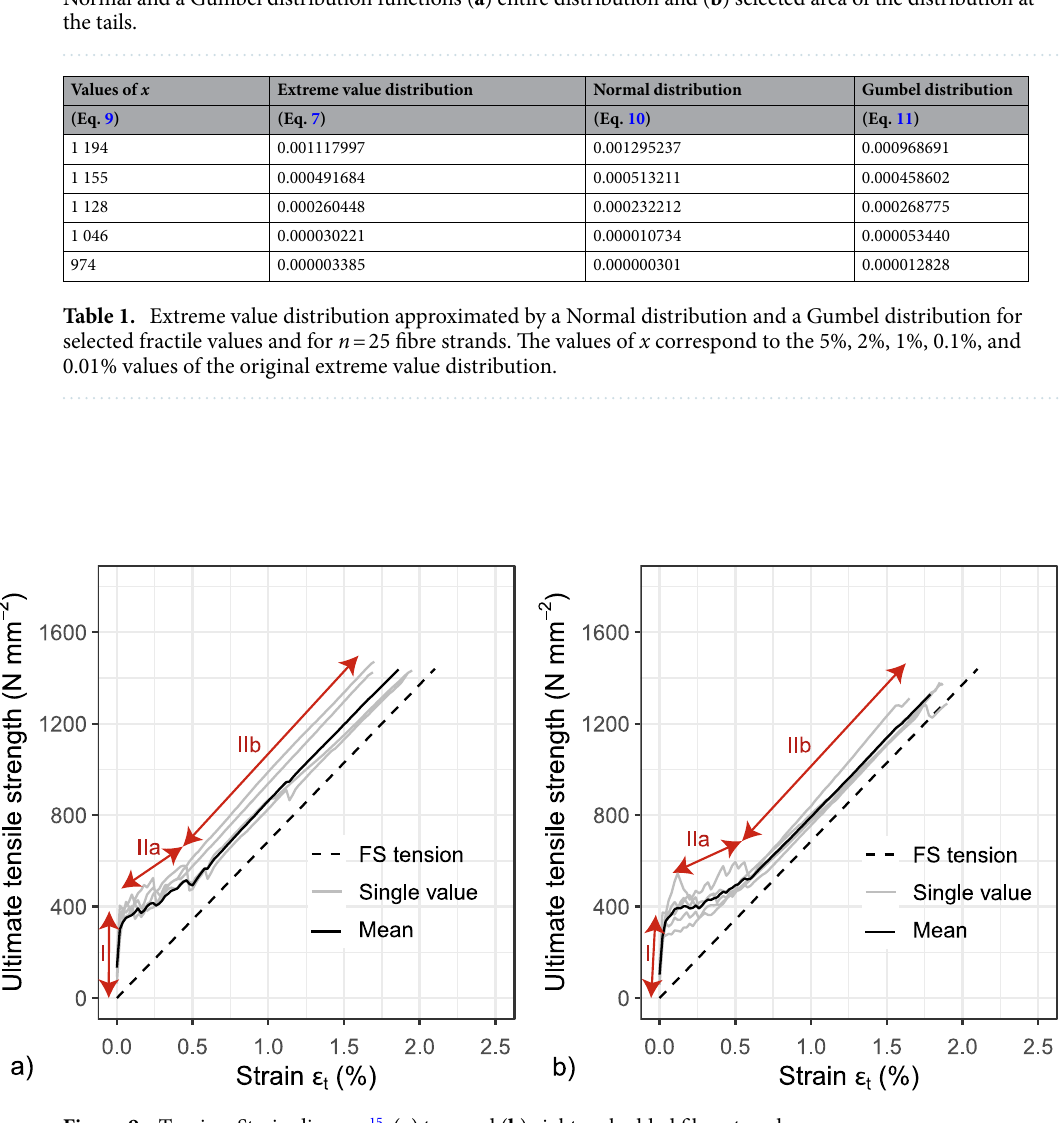
Figure 9. Tension-Strain diagram 15 : ( a ) two and ( b ) eight embedded fibre